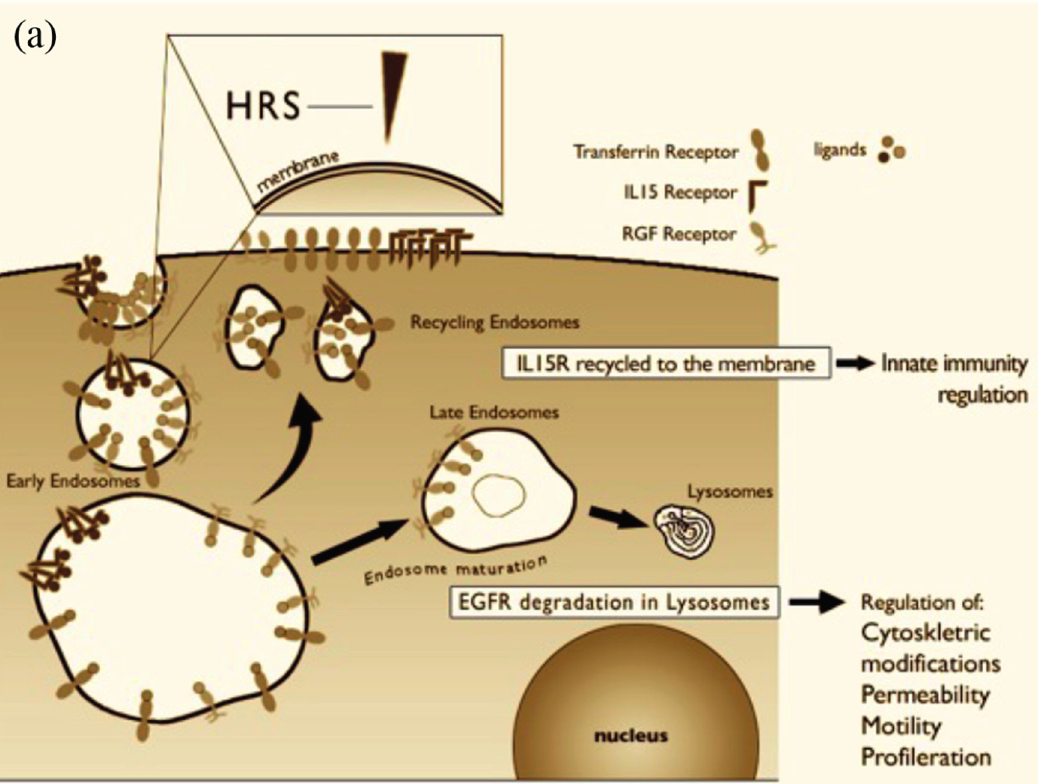
Figure 3. ( a ) Schematic representation of receptor-mediated endocytosis. Trafficking of IL-15R- α , EGFR and transferrin in normal cells. The ligands bind to their receptors on the cell surface. The ligand/receptor complexes are internalized by a process of endocytosis and enter into vesicles “early”. The protein hepatocyte growth factor regulated substrate (HRS) regulates the maturation of endosomes from early to late. If HRS is not properly localized on the membrane of early endosomes, vesicular trafficking is altered. IL-15 and transferrin entering the compartment vesicular recycling are transported to the cell membrane. Receptor tyrosine kinases, such as EGFR, are only partially recycled because their principal destiny is to be transported in the late vesicular compartments to be degraded in lysosomes. When these receptors are in the early compartment, they can still signal within the cell. These transport phenomena within the cell regulate the duration of the activation of the receptors regulating processes essential for cell function, such as activation of innate immunity, cell proliferation, regulation of the actin cytoskeleton, motility and permeability. Alterations in the maturation of endosomes may therefore impair the functionality of the cell in many different ways; and ( b ) Effect of P31–43 on vesicular trafficking of IL-15R- α , EGFR and transferrin within the cells. The peptide P31–43, due to a sequence homology with HRS, interferes with its correct localization at the level of early endosomes, with a consequent slowing of the maturation of endosomes from early to late, prolonged activation of EGFR, and an increase of transferrin on the cellular membrane and trans-presented IL-15. The main biological consequences at the level of enterocytes of the altered trafficking of these receptors are: Increased proliferation, an alteration in permeability, alterations in the cytoskeleton and cell shape, and an increase in the innate immune